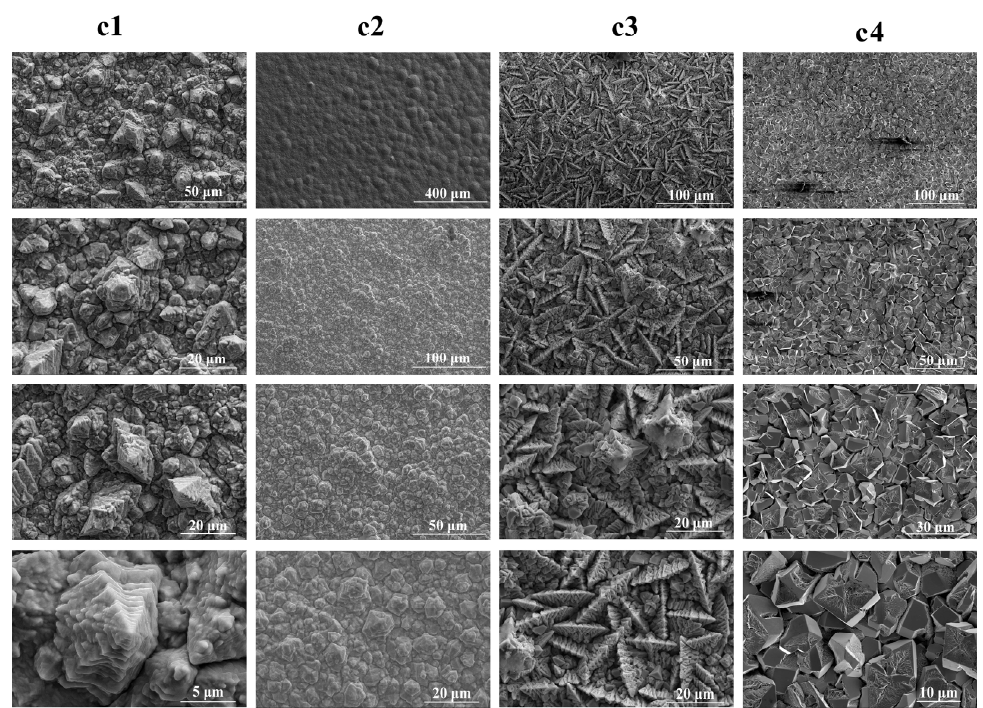
Figure 9. SEM images of copper surface under different reverse pulse duty cycle. ( b1 ) is 20%;( b2 ) is 40%;( b3 ) is 60%;( b4 ) is 80%;